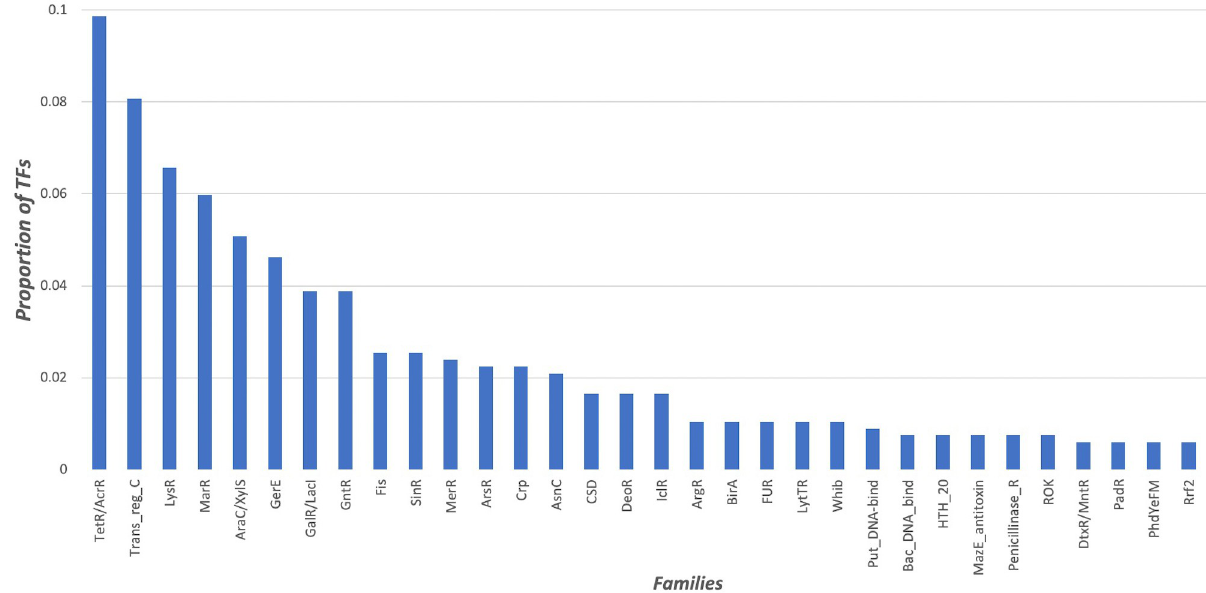
Fig 1. Distribution of TF families. In x axis is indicated the 32 families identified in this work represent 78% of the total proteins identified in this version. The abundance of TFs is shown on the y axis.